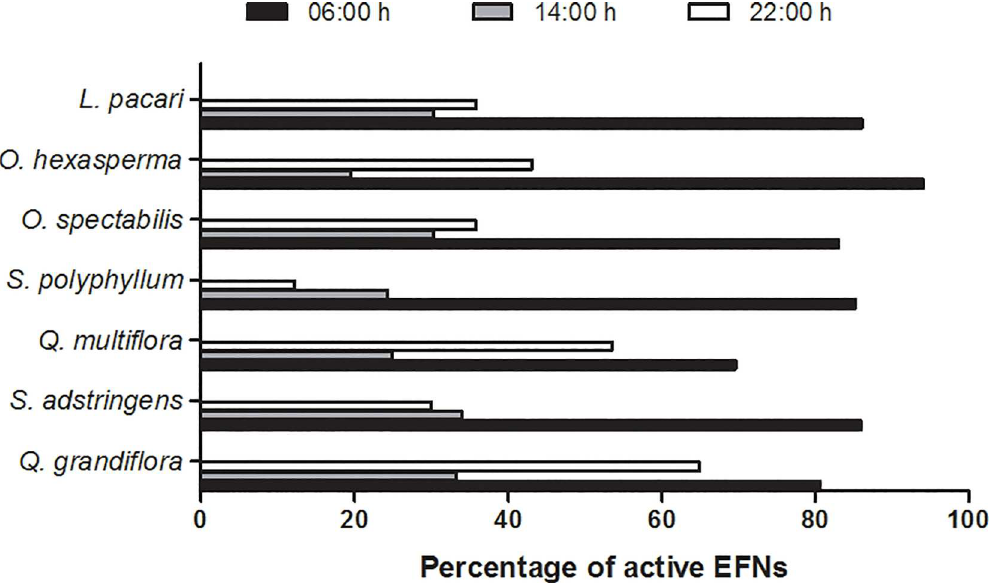
Fig 5. Percentage of active EFNs (n = 210 glands) during all the period of EFNs productivity (since the beginning of their activity until their necrosis) in each of the seven assessed plant species at three distinct times of the